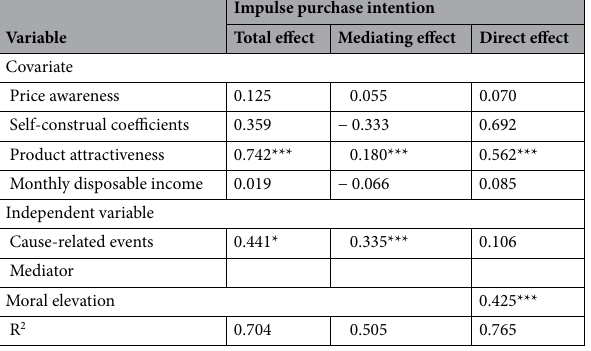
Table 5. The mediating effect of moral elevation. *, **, *** in the table represent P < 0.05, 0.01 and 0.001 respectively.